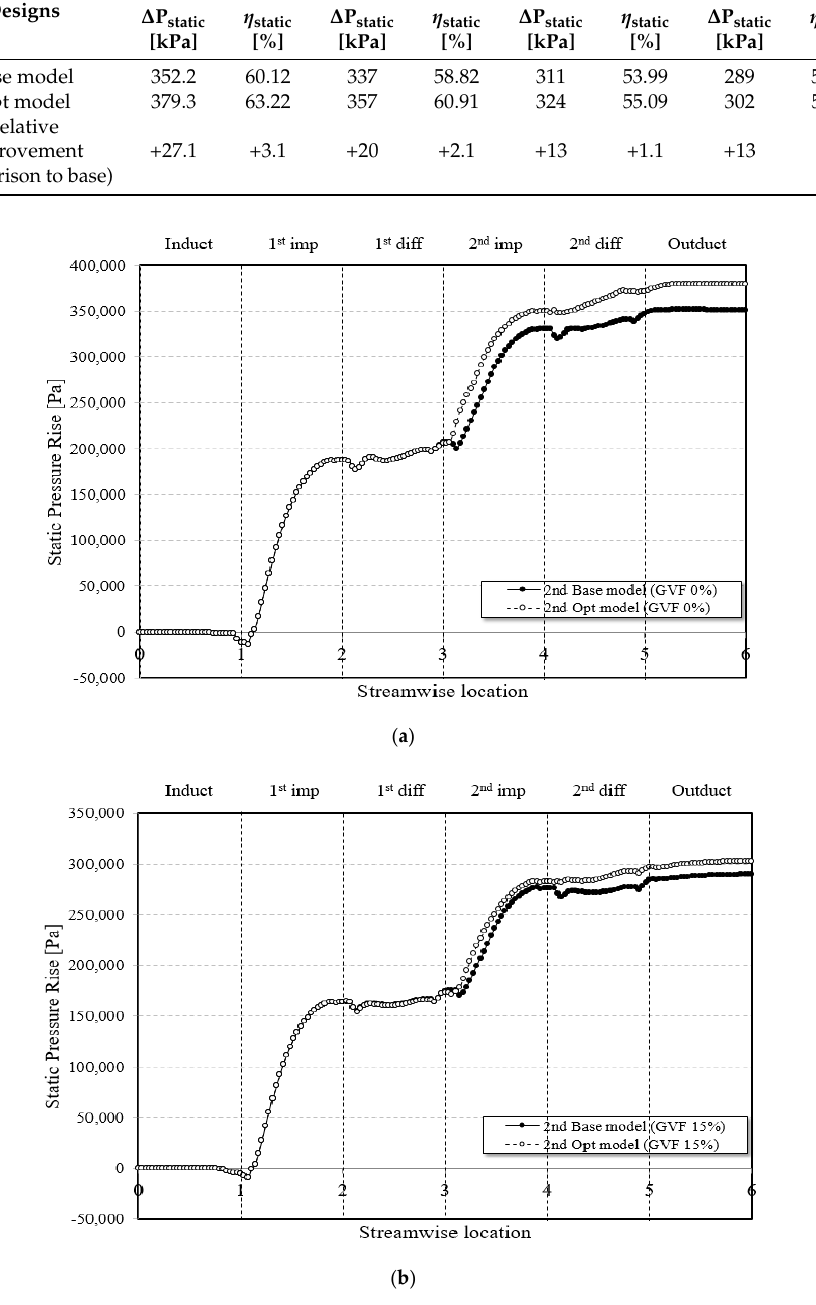
Table 6. The o ptimum model increased performance compared to the base model.